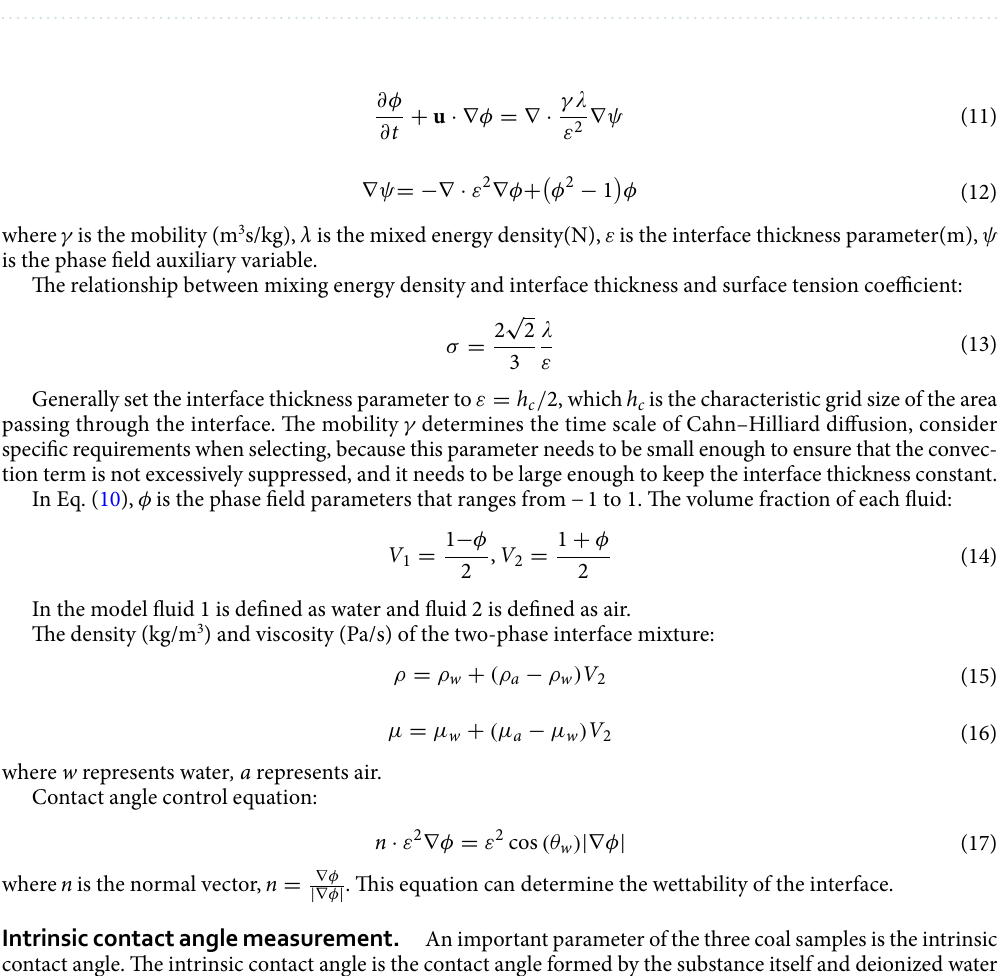
Figure 6. Diagram of different roughness